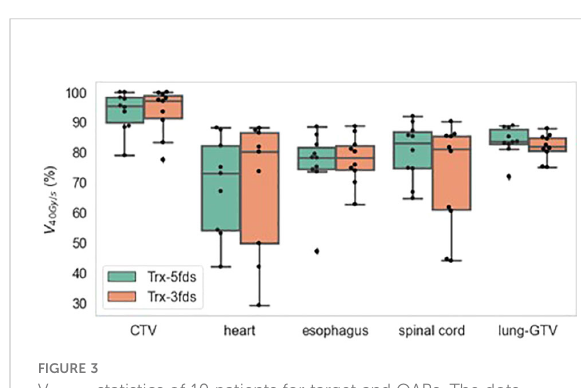
FIGURE 3 V 40Gy/s statistics of 10 patients for target and OARs. The dots represent each patient, the line inside the box represents the mean value, and the error bars outside the box represent the 25- 75 th percentile of the scattered